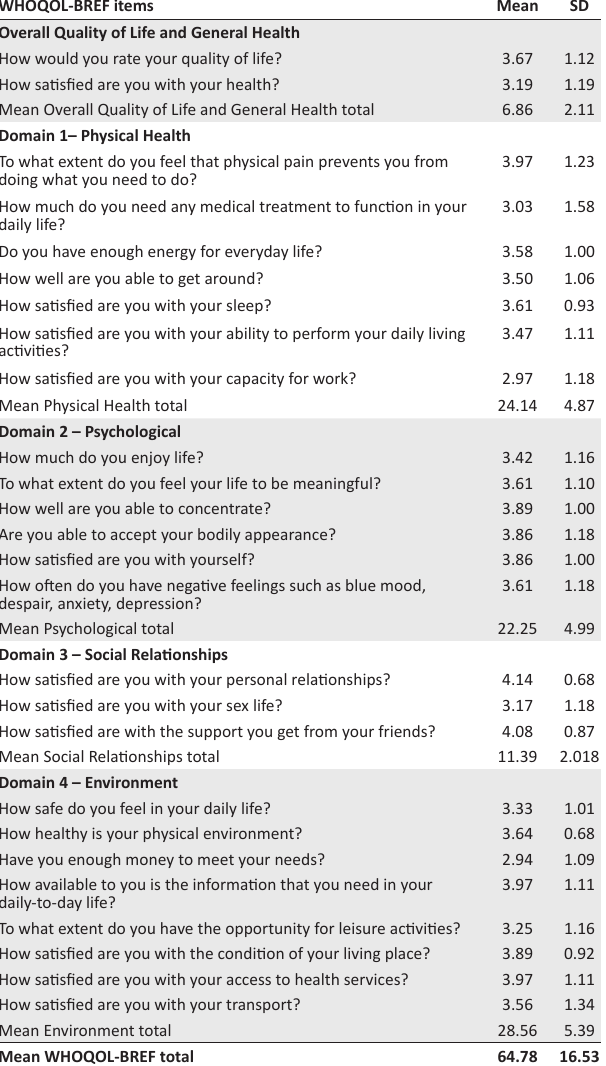
TABLE 4: Descriptive statistics of the World Health Organization Quality of Life Assessment-BREF scores ( n = 36) WHOQOL-BREF items